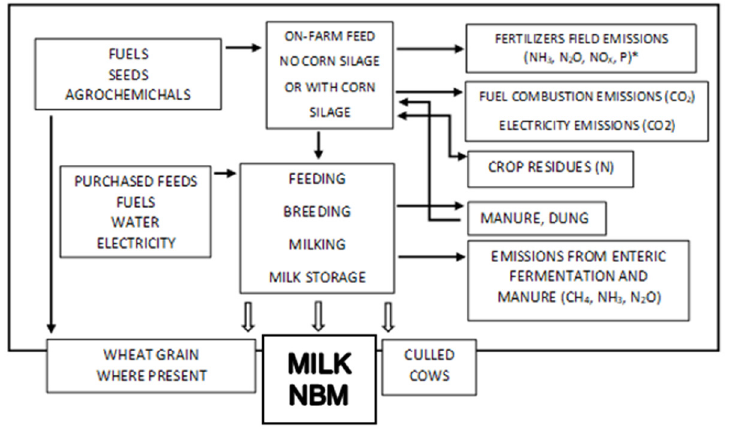
Figure 1. Cradle-to-farm-gate system boundaries of the production of 1 kg of normalized buffalo milk (NBM). The milk, functional unit (FU) is carried out from non-corn silage (NCS) and corn silage (CS) based systems. Corn silage must be included as on-farm feed in the CS system, wheat crop in two farms for each system. The solid line represents the system boundaries of the